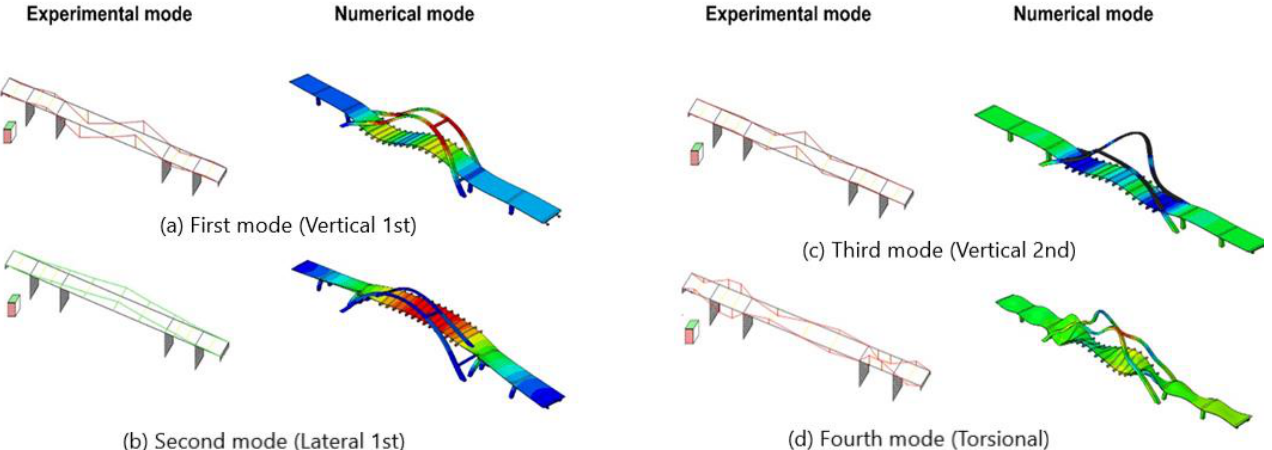
Figure 12. Comparison of the modes of vibration obtained from the in situ tests and from the numerical calculations: ( a ) first mode (1st vertical); ( b ) second mode (1st lateral); ( c ) third mode (2nd vertical); ( d ) fourth mode (1st torsional).